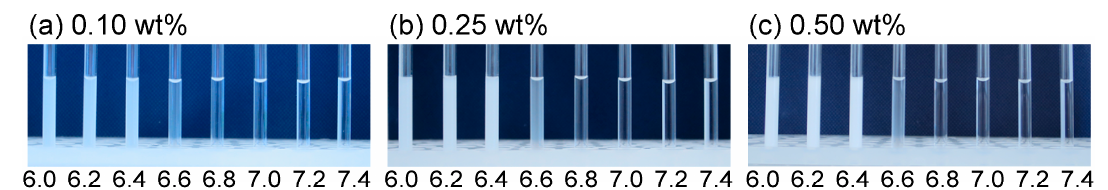
Figure 3. Phase transition behaviors of ( a ) 0.10 wt%, ( b ) 0.25 wt%, and ( c ) 0.50 wt% of the 40 mol% DEGDMA-based microgel in 100 mM phosphate buffer, pH 6.0 to 7.4 with 0.2 increments at room temperature.